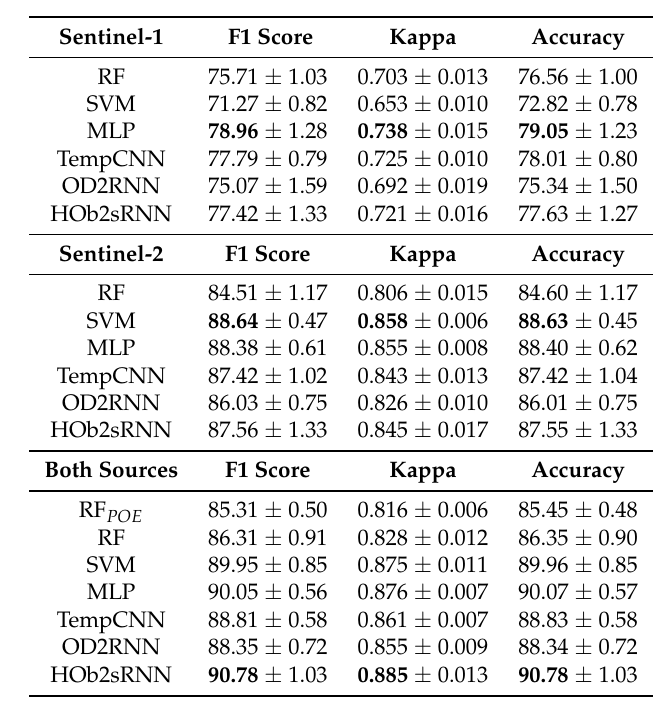
Table 7. F1 score, Kappa, and Accuracy of the different methods when considering the per-source ablation analysis on the Senegalese site (results averaged over ten random splits). We have highlighted the best scores in